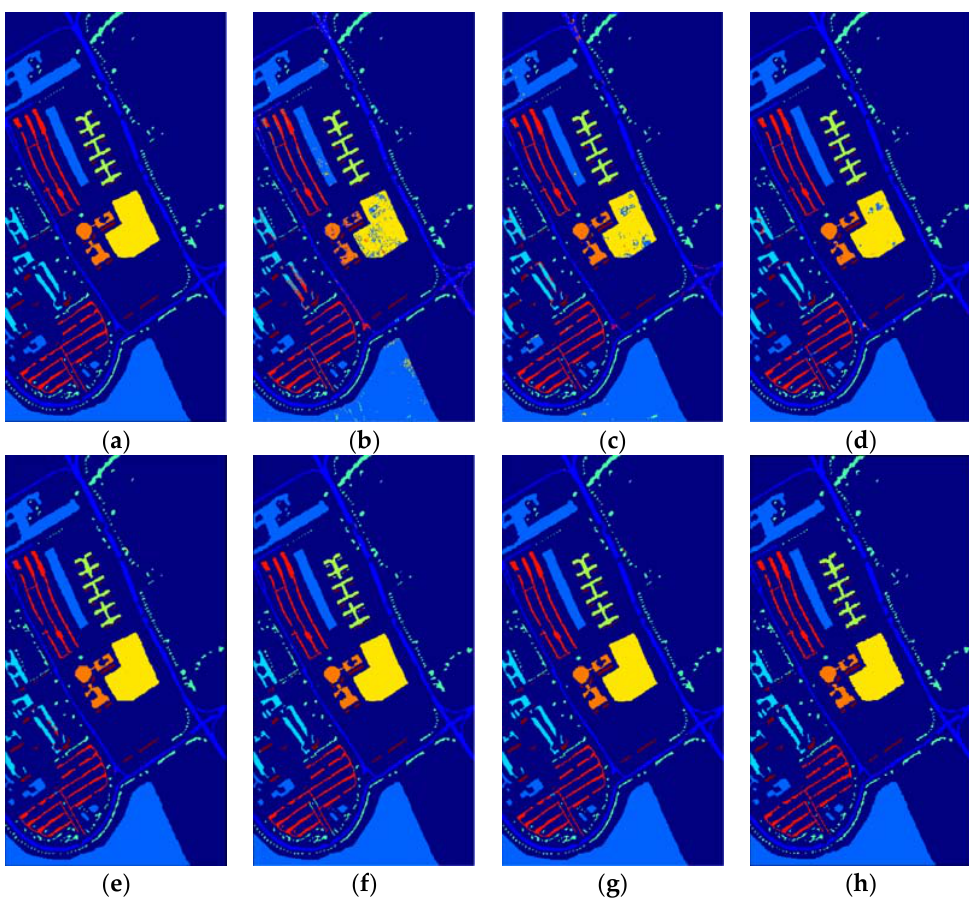
Figure 11. Classification maps for the Pavia University data set. ( a ) Ground truth. ( b ) SVM. ( c ) 3D-CNN.